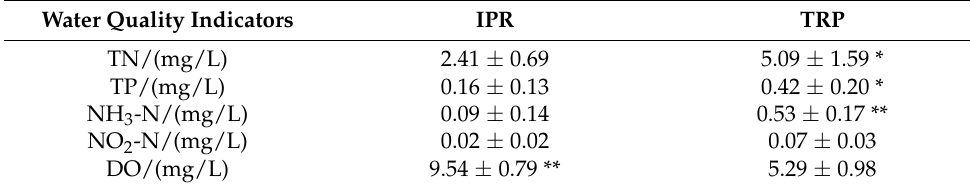
Table 2. Water quality indicators of IPR and TRP.